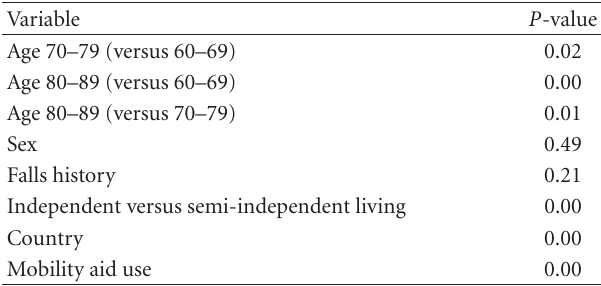
Table 4: Unadjusted P -values from Welch’s two sample t -tests comparing DEMMI scores amongst variables of